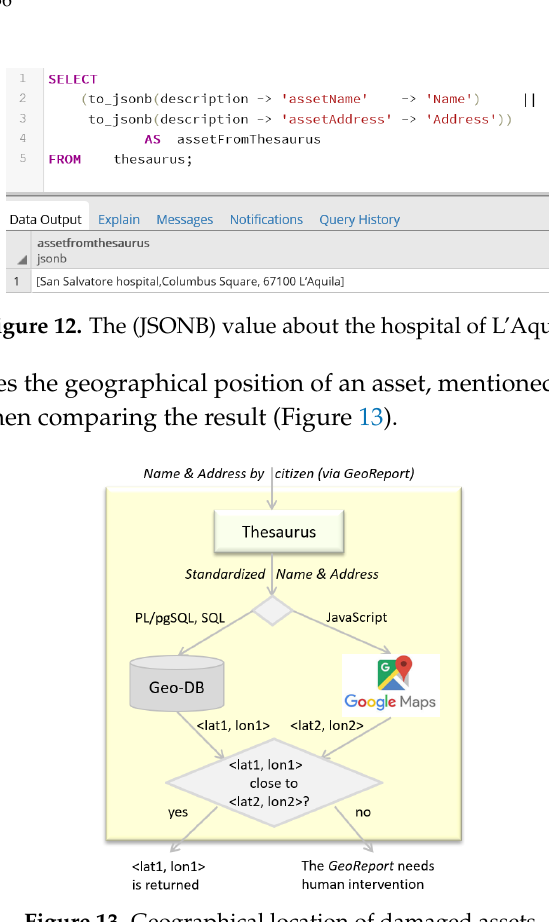
Figure 13. Geographical location of damaged